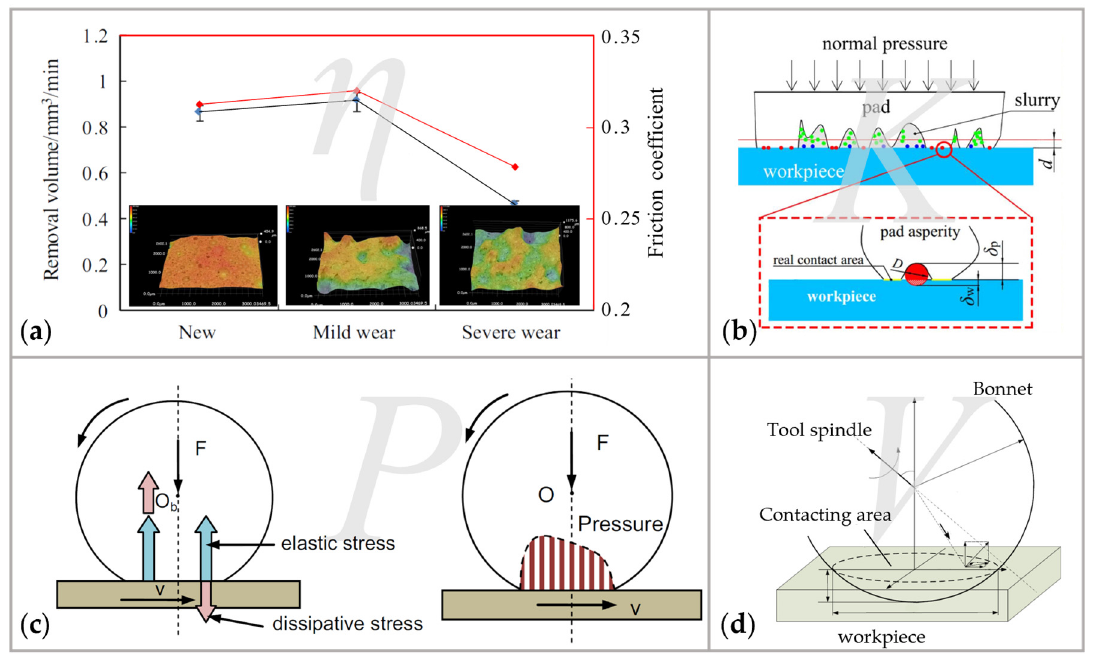
Figure 18. The material removal mechanism for BP: ( a ) The comparison between the removal volume and friction coefficient, and surface texture of bonnet tools with the three wear conditions. Reproduced with permission from [138]; ( b ) The contact behavior of a single abrasive particle with the workpiece and pad asperity [139]; ( c ) The sketch of pressure distribution for the rolling bonnet. Reproduced with permission from [133]; ( d ) The kinematic model of BP. Reproduced with permission from [137].